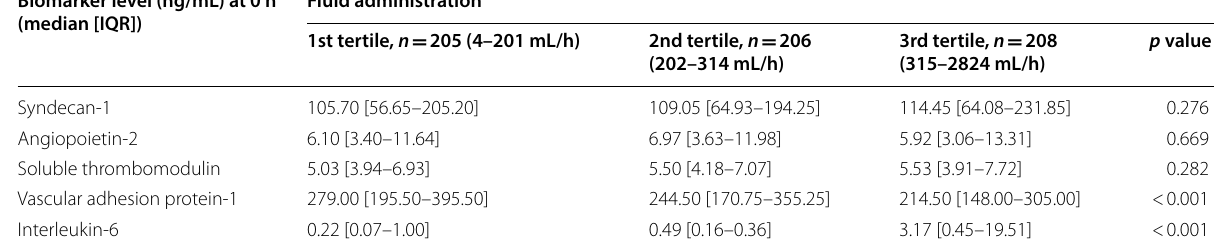
IQR interquartile range